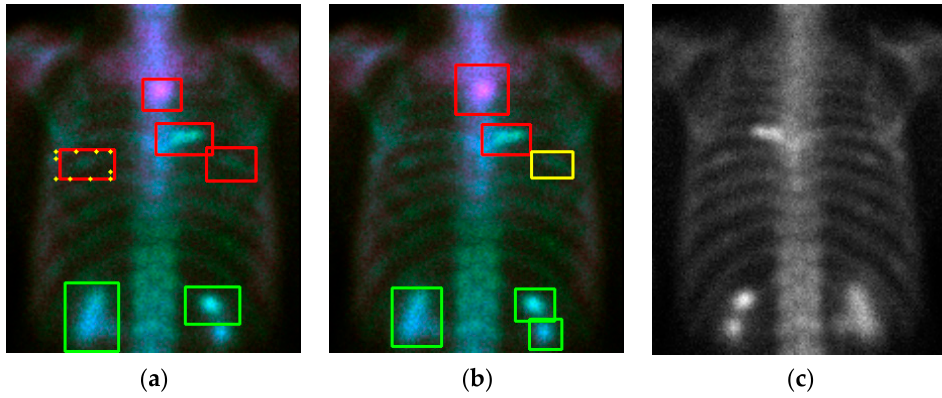
Figure 6. The qualitative results (case number 125) of our model. ( a ) Detection and classification results; ( b ) ground truth; ( c ) the raw PA view (without flipping).